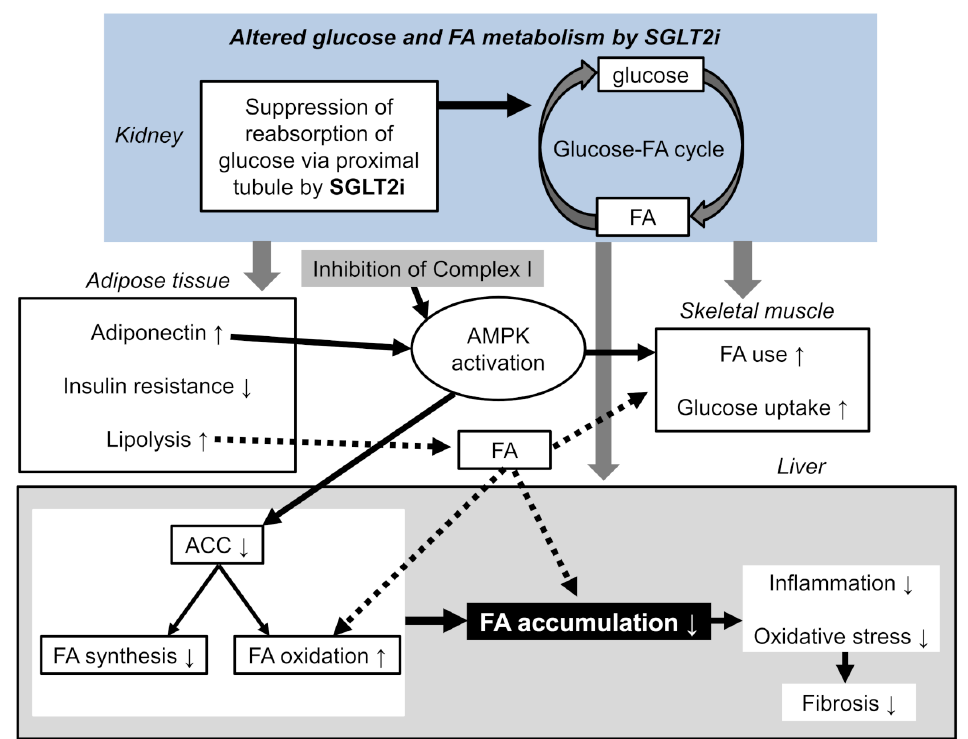
Figure 3. Possible hepatic protective mechanisms by SGLT2 inhibitors. ACC, acetyl-CoA carboxylase; AMPK, adenosine monophosphate-activated protein kinase; FA, fatty acids. The up and down arrows in white boxes indicate an increase and a decrease,